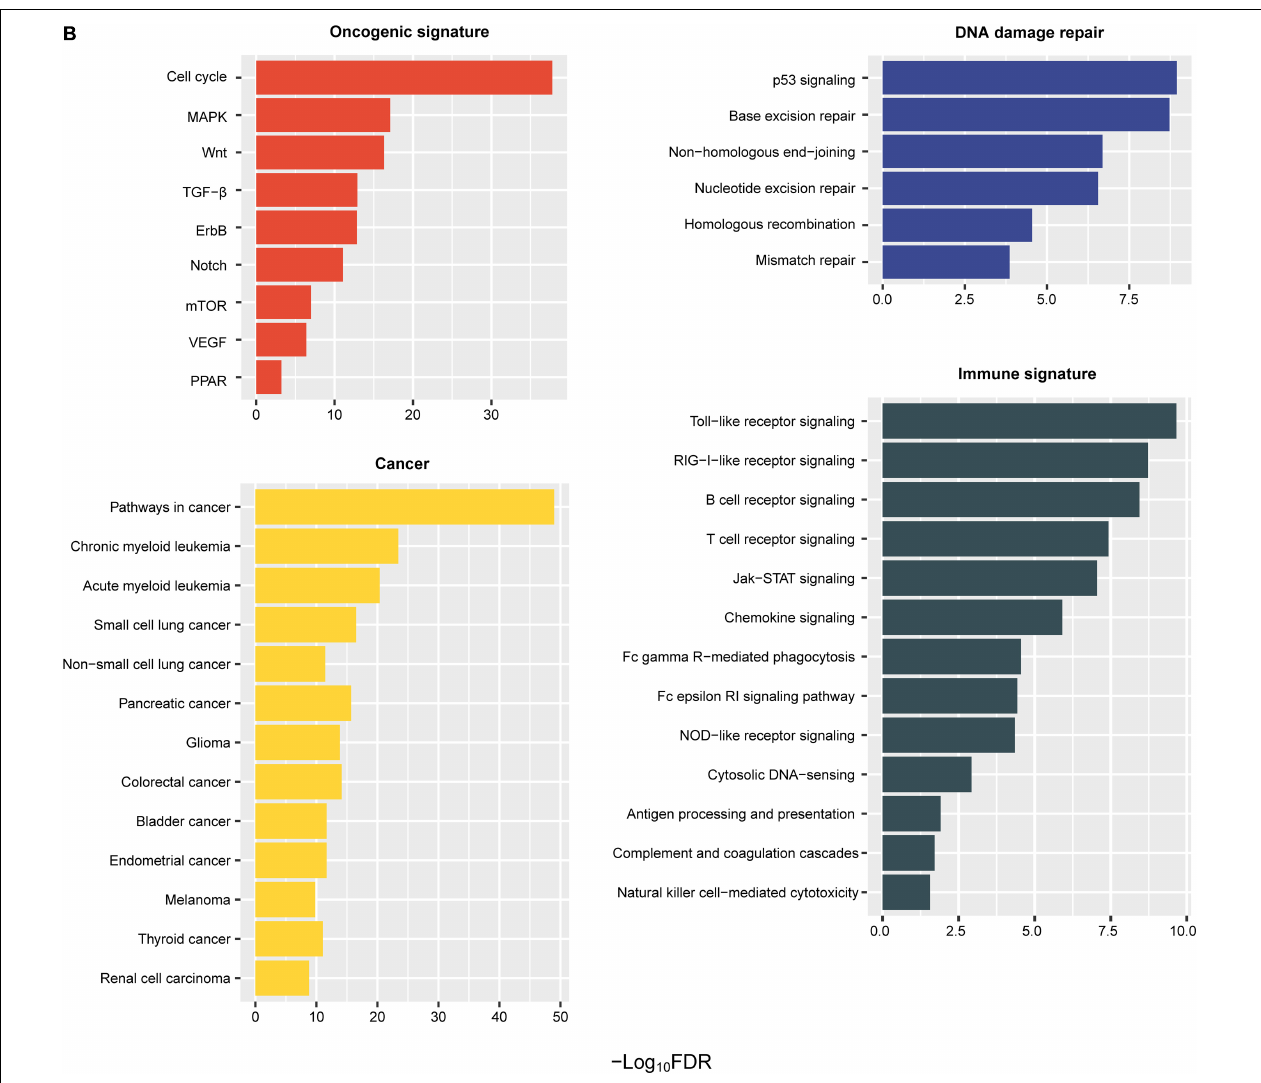
FIGURE 4 | Protein–protein interaction network of E1A binding protein p300 (EP300). (A) A protein–protein interaction network of EP300 identified by BioGRID (Stark et al., 2006). The interactions evidenced by at least 10 publications are shown. (B) Kyoto Encyclopedia of Genes and Genomes (KEGG) pathways significantly associated with the 741 interactors of EP300 identified by Gene Set Enrichment Analysis (GSEA) (Subramanian et al., 2005) with a threshold of false discovery rate (FDR) <